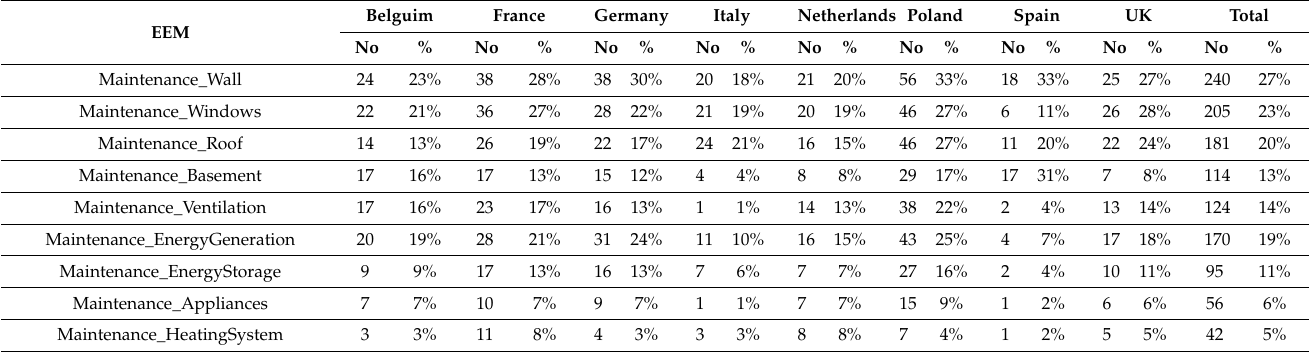
Table 6. Distribution of sample size and percentage of observations choosing each EERM (of